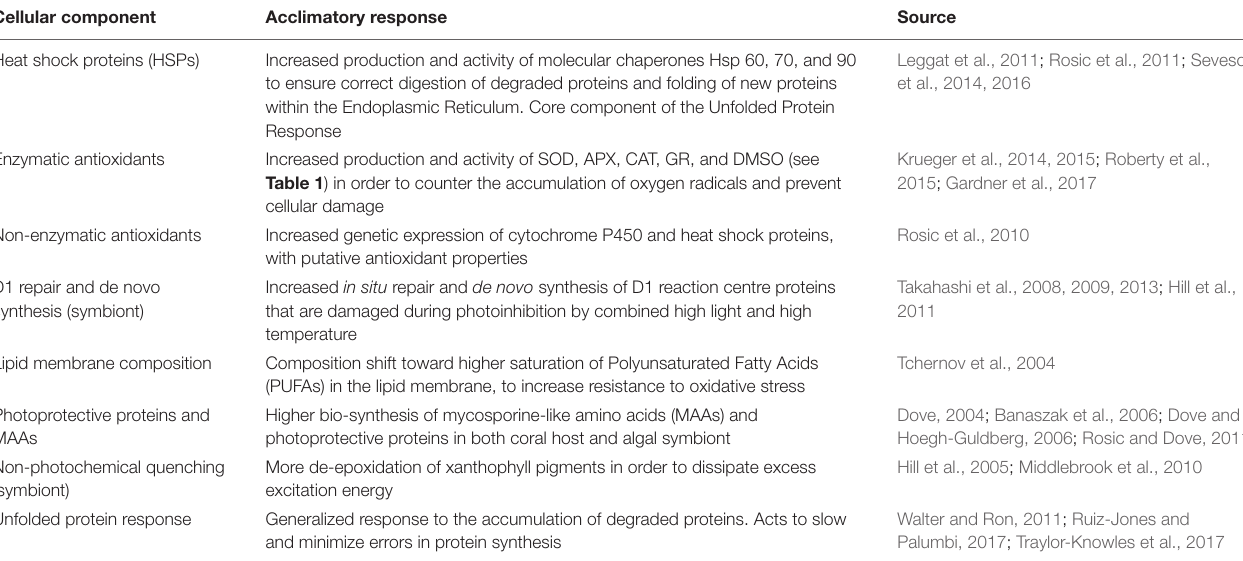
TABLE 4 | Demonstrated acclamatory responses of coral host and/or symbiotic algal cells to thermal stress. Cellular